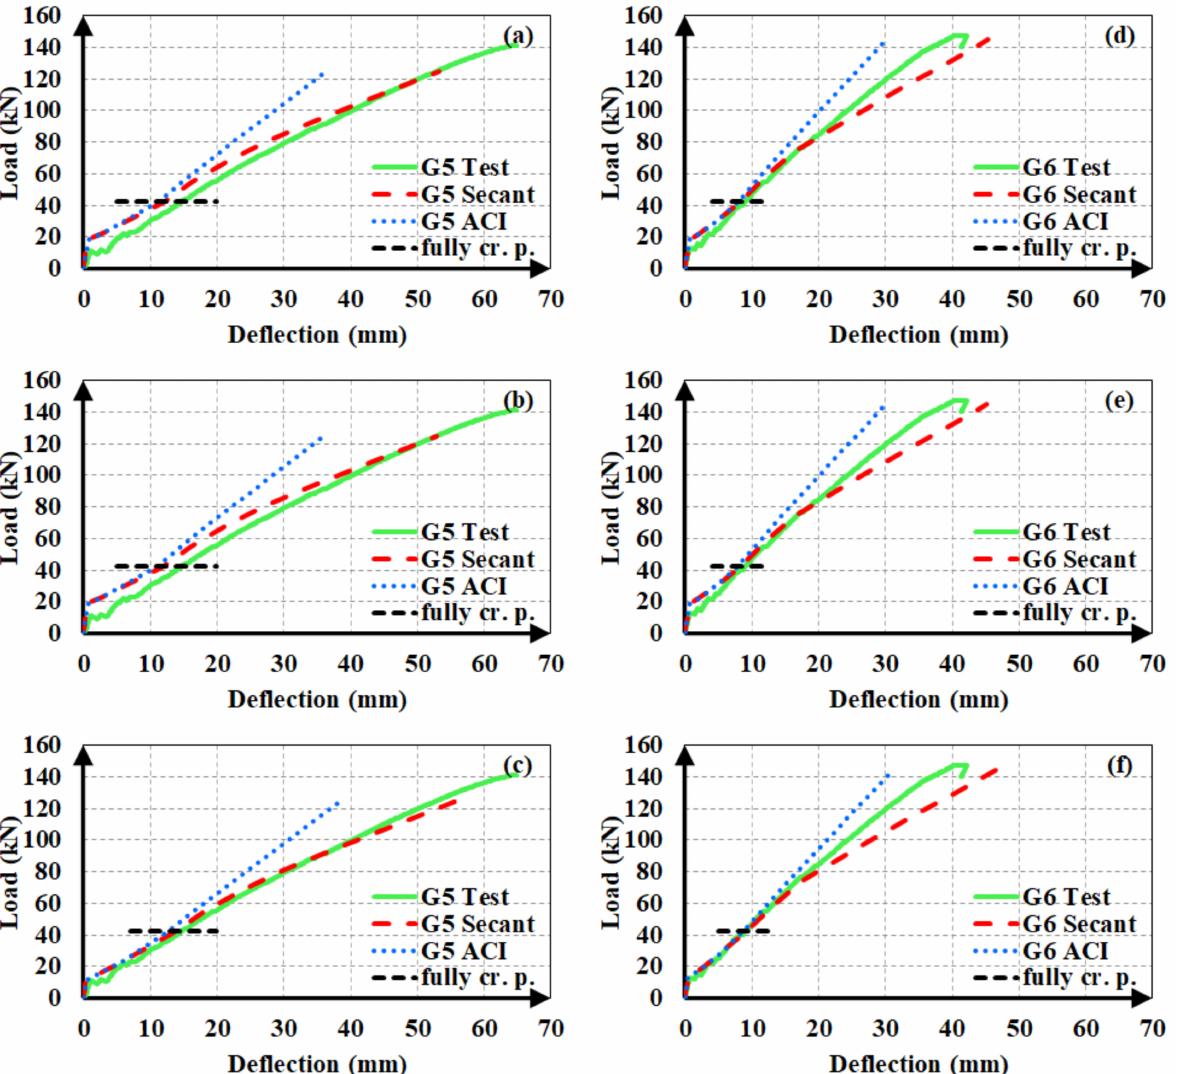
Figure 17. Load-deflection estimates of beams G5 and G6 using the analytical cracking moments from ( a , d ) gross; ( b , e ) uncracked transformed cross-sections; and ( c , f ) experimental cracking